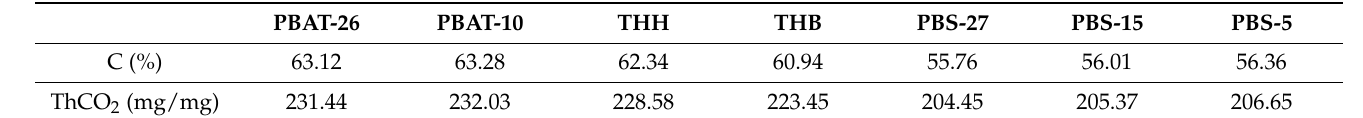
Table 3. The carbon content and ThCO 2 of PBAT and PBS mulches.